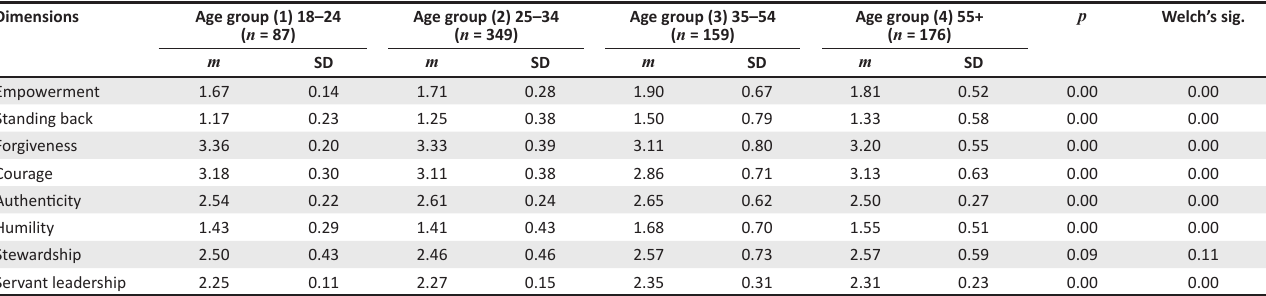
TABLE 5: Servant leadership observations per age group. Dimensions Empowerment